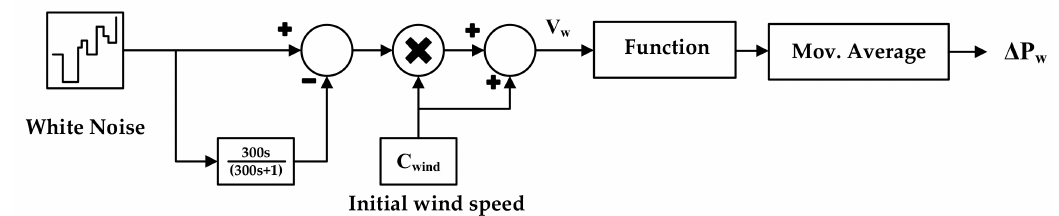
Figure A1. Model for wind power generation.